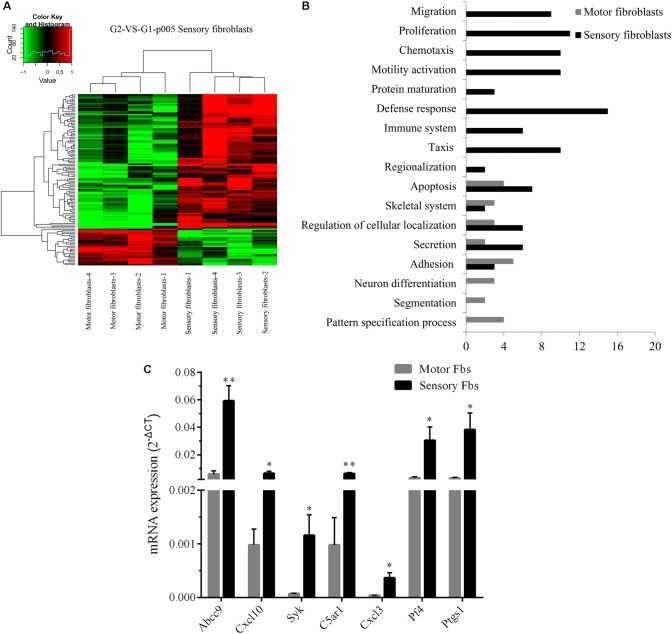
(A) Heatmap and cluster dendrogram of the 121 differentially expressed genes that had more than twofold changes (sensory fibroblasts/motor fibroblasts) in their expression of four replicates, n = 12 rats. (B) Histogram showing functional categorization of the 121 differentially expressed genes between motor and sensory fibroblasts according to their main biological functions collected from DAVID Bioinformatic Resources 6.7 (Rat) and Gene Ontology, in which the different functional categories of the higher expressed genes are shown on the ordinate, and the number of the higher expressed genes within each categories of sensory or motor fibroblasts is shown on the abscissa. (C) The qPCR data showing that Abcc9, Cxcl10, Cxcl3, Syk, C5ar1, Pf4, Ptgs1, presented the higher mRNA level in sensory fibroblasts than in motor fibroblasts. Data are expressed as means ± SEM of three independent experiments (each in triplicate). GAPDH served as an internal control. p = 0.009, p = 0.031, p = 0.047, p = 0.003, p = 0.027, p = 0.049, and p = 0.045, respectively, ∗p < 0.05, ∗∗p < 0.01 vs. motor Fbs, unpaired t-test, n = 9–10 rats.